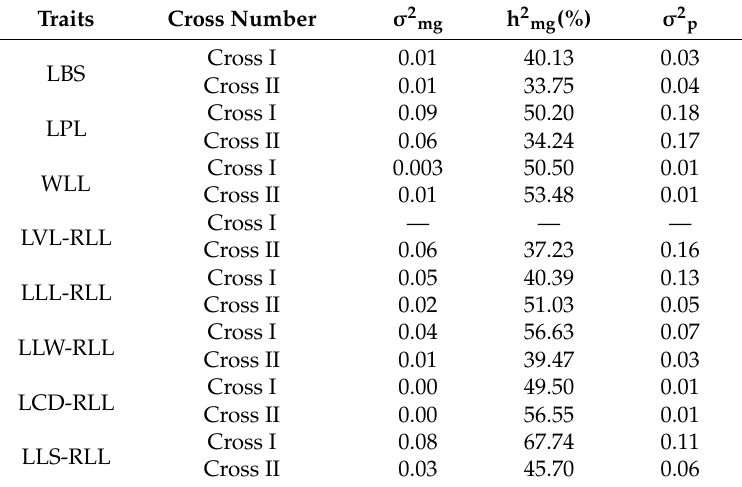
Table 5. The major gene heritability of leaf